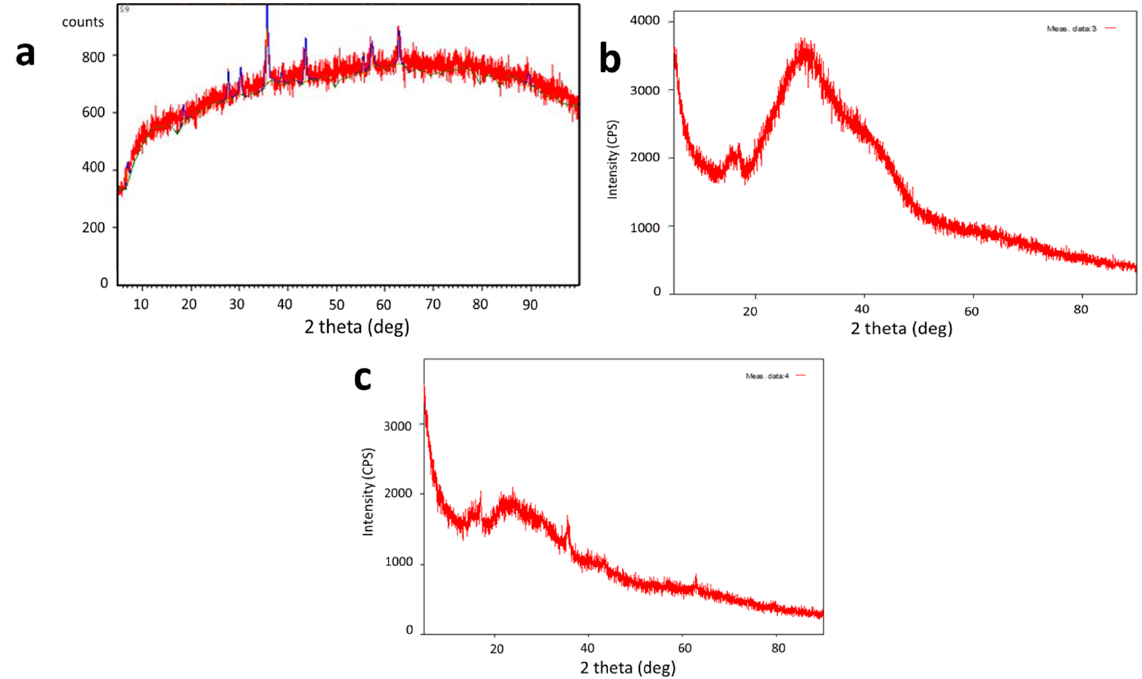
Figure 3. XRD analysis of ( a ) SPIONs ( b ) Alginate beads ( c ) Alginate–SPIONs microspheres.